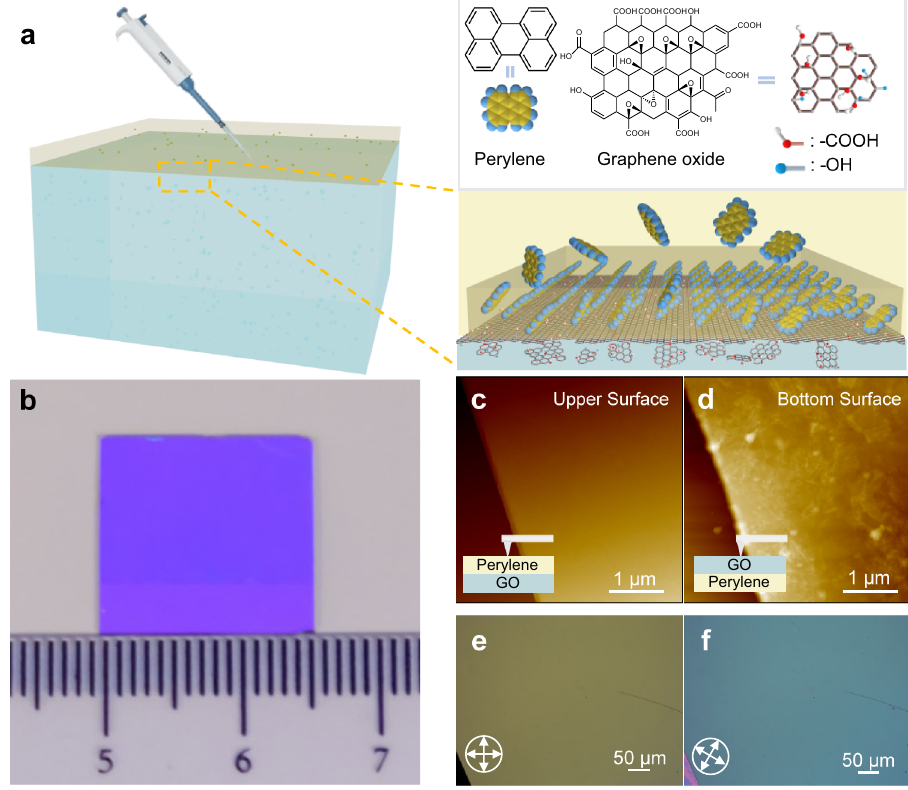
Fig. 1 | Coassembly and morphology of bilayer heterostructure. a Schematic illustrationofthecoassemblyofGOandperyleneattheinterface. b Photographof theassembled fi lmonaSiO 2 /Sisubstrateunderdaylight.AFMimagesof c theupper